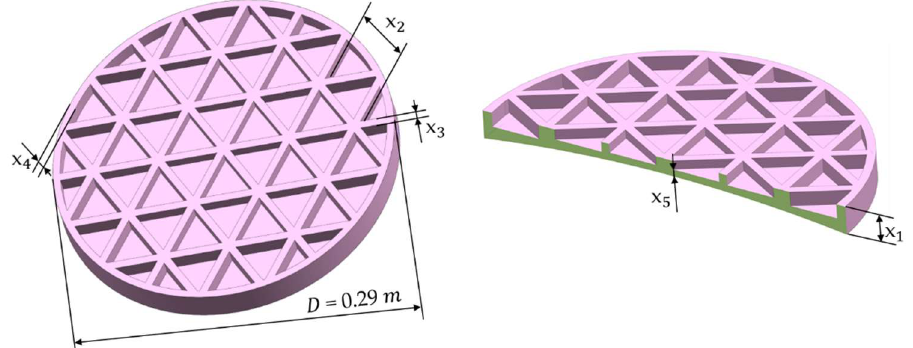
Figure 5. Reflector structure diagram.